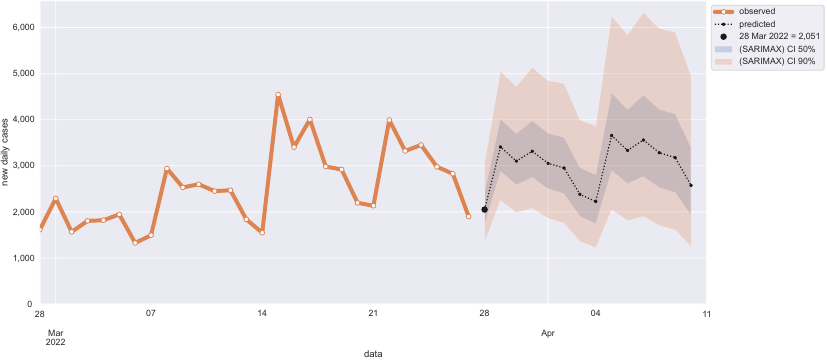
Figure 7. Out-of-sample 14-days prediction of daily new COVID-19 cases in Calabria with SARIMA model.